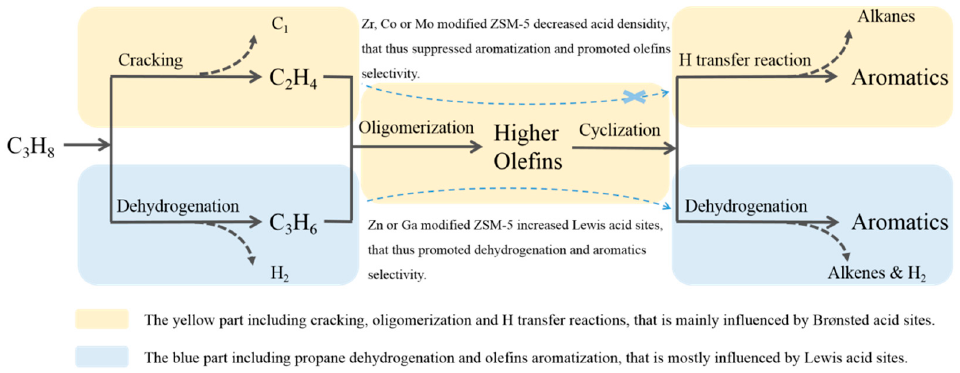
Figure 9. Diagram of the reaction mechanism of propane conversion over metal-modified HZSM-5.